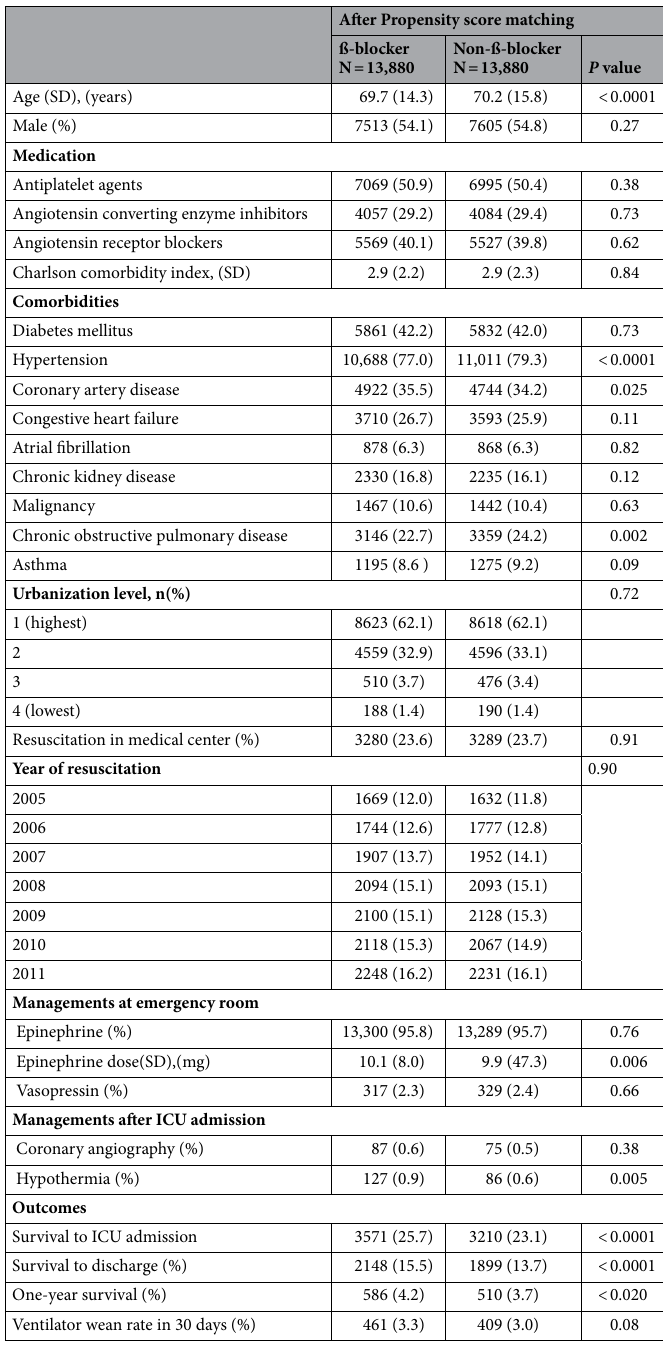
Table 2. Baseline characteristics, management and outcomes of patient with/without ß-blocker use after